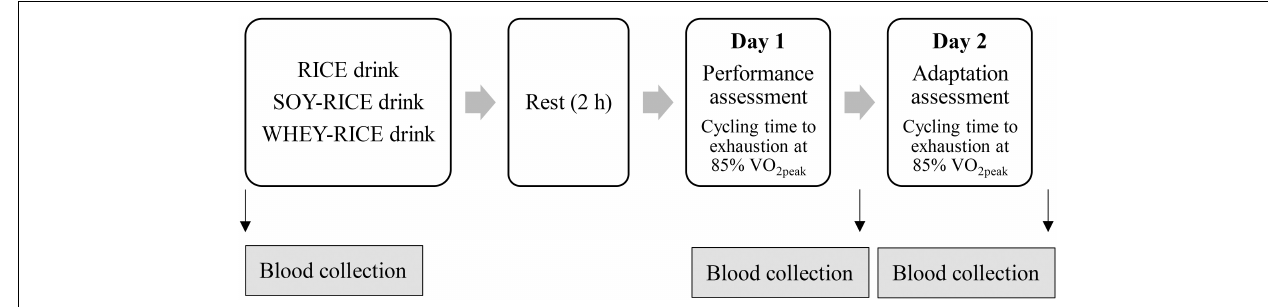
FIGURE 1 | The experimental design consisted of three isocaloric carbohydrate drinks ( Table 1 ) supplemented 2 h before endurance performance test at 85% ˙V 2peak : RICE alone drink ( n = 7), SOY-RICE drink ( n = 7), and WHEY-RICE drink ( n = 7) with a 7-day washout period between trials. The magnitude of fatigue recovery is indicated by performance improvement from Day 1 to Day 2 against the same cycling performance test. Arrow indicates the time of blood collection for measurements of creatine kinase (CK), interleukin-6 (IL-6), reduced-to-oxidized glutathione (GSH-to-GSSG ratio), and ferric reducing antioxidant power (FRAP). RICE alone drink (carbohydrate 95%, protein 4%, and fat 1%), SOY-RICE drink (carbohydrate 82%, protein 10%, and fat 8%), and WHEY-RICE drink (carbohydrate 76%, protein 20%, and fat 4%) in